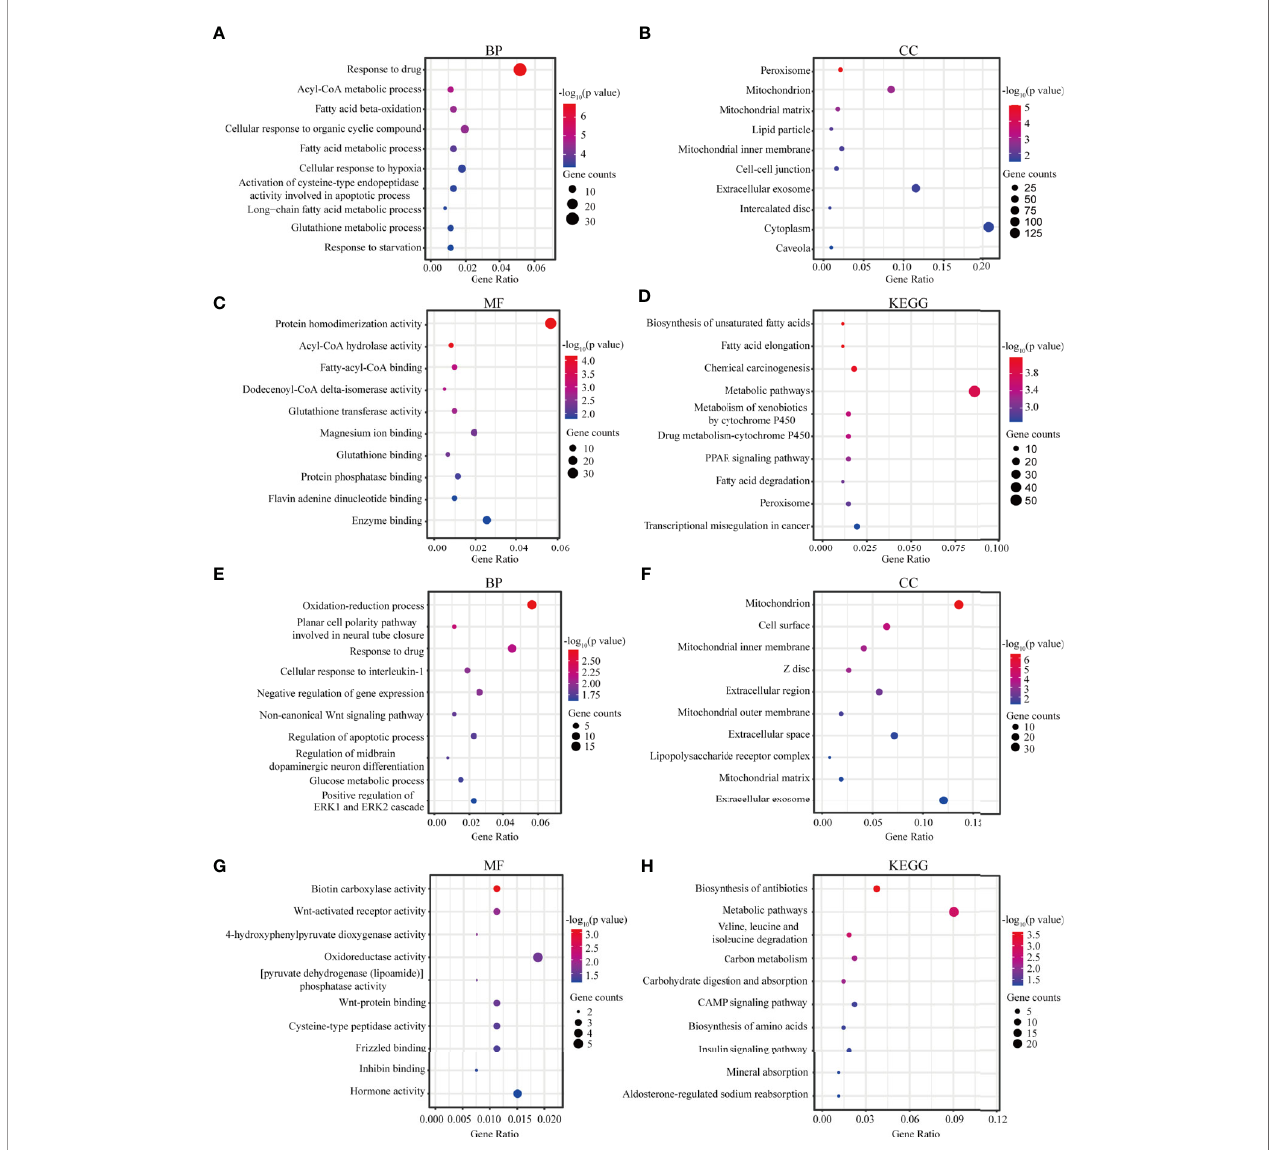
FIGURE 4 | Functionalanalysis. (A – C) Biological process, Cellular component, and Molecular function GO terms for genes in the yellow module. (D) KEGG analysis for genes in the yellow module. (E – G) Biological process, Cellular component, and Molecular function GO terms for genes in the green module. (H) KEGG analysisfor genes in the green module. GO, Gene Ontology;KEGG,Kyoto Encyclopedia of Genes andGenomes; BP, biological process; CC, cellular component; MF, molecular